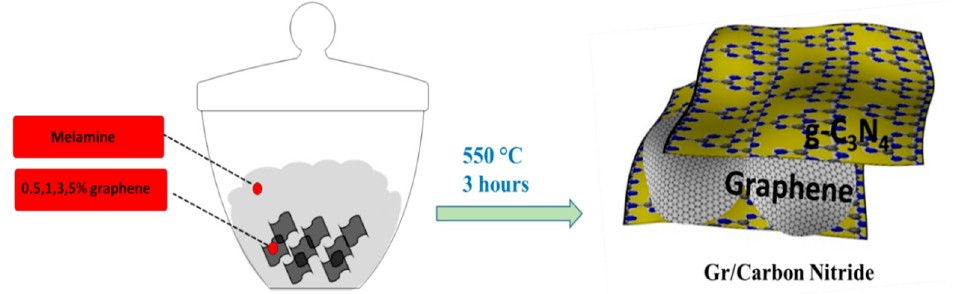
Figure 10. Schematic steps of the synthesis of Gr/g-C 3 N 4